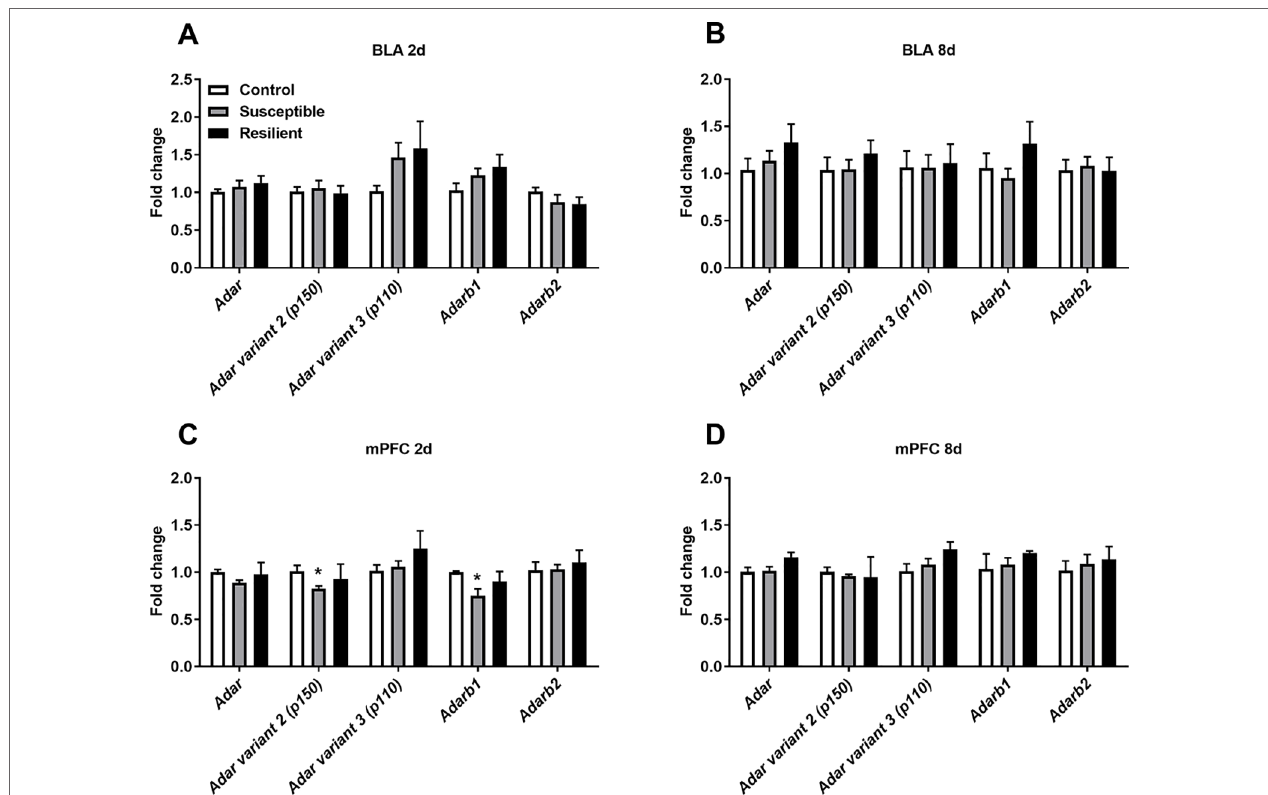
FIGURE 2 | CSDS acutely alters transcripts encoding adenosine deaminases acting on RNA (ADARs) within the medial prefrontal cortex (mPFC) of susceptible mice. Following CSDS, no changes in Adar, Adarb1, or Adarb2 mRNA levels were observed within the basolateral amygdala (BLA) at 2 days (A) or 8 days (B) . CSDS significantly decreased the expression levels of Adar variant 2 (p150) and Adarb1 mRNA in the mPFC only in mice susceptible to the CSDS procedure (C) . No changes were observed within the mPFC 8 days following CSDS (D) . Control 2 days, n = 7; susceptible 2 days, n = 10; resilient 2 days, n = 4; control 8 days, n = 5–7; susceptible 8 days, n = 7; resilient 8 days, n = 3. * p < 0.05, one-way ANOVA with Sidak post hoc